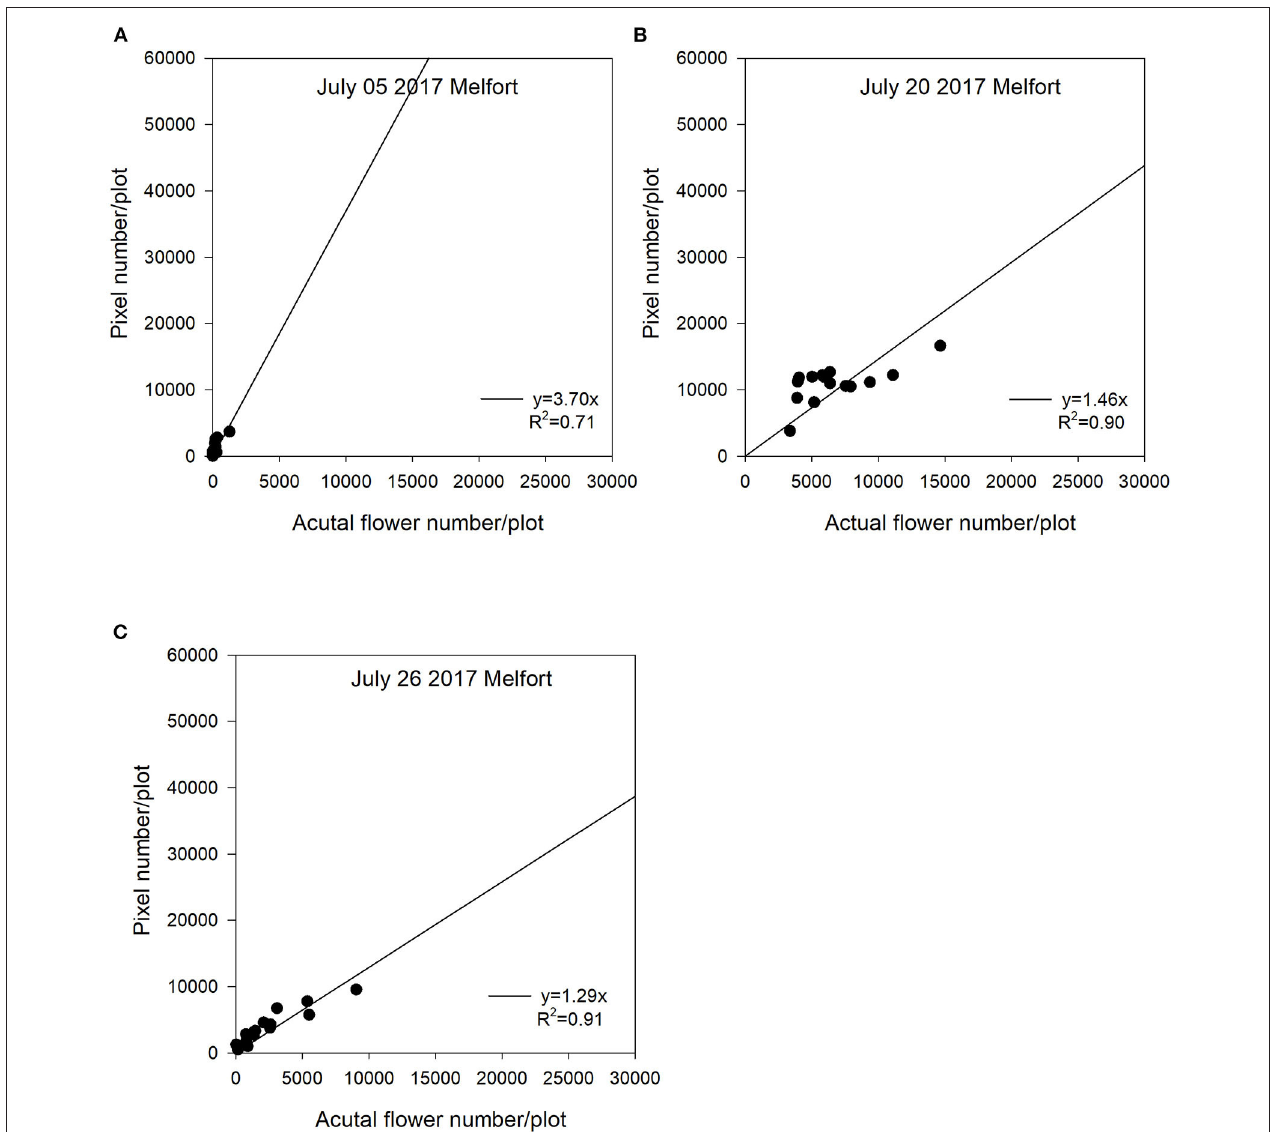
FIGURE 6 | The relationship between actual flower numbers per plot and pixel numbers extracted from aerial images during the flowering stage at Melfort, SK, Canada in 2017. Actual flower numbers per plot were manually measured. Pixel number per plot was detected by the thresholding method. (A) Regression equation for July 05, 2017: y = 3.70x, R 2 = 0.71. (B) Regression equation for July 20, 2017: y = 1.46x, R 2 = 0.90. (C) Regression equation for July 26, 2017: y = 1.29x, R 2 =